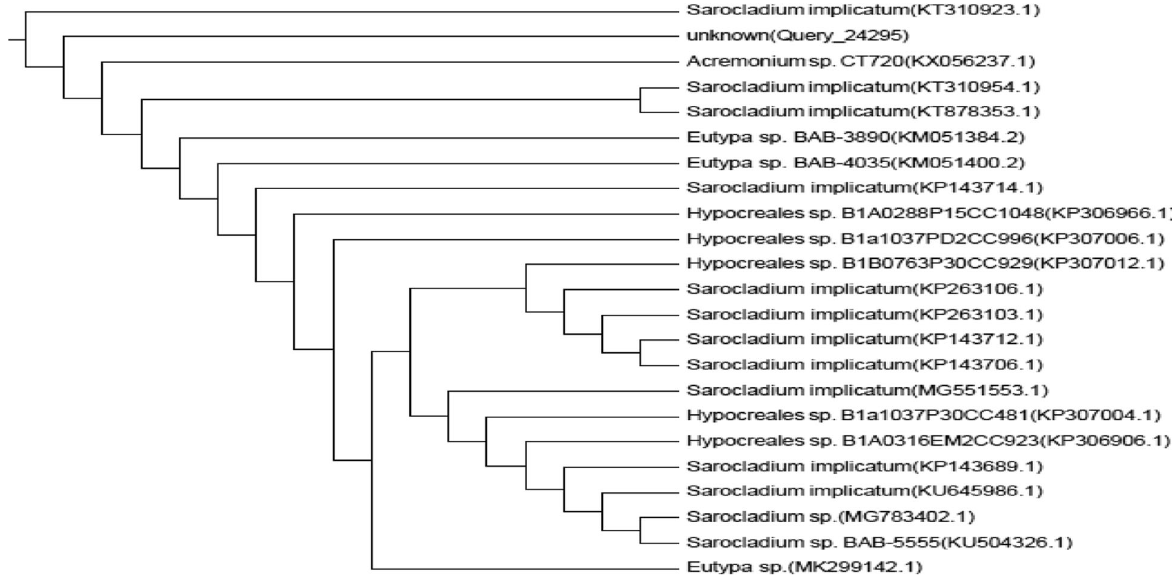
Fig. 2 Phylogenetic dendogram of different fungal isolates accessions revealed by average linkage cluster analysis based on 18S rRNA partial sequence